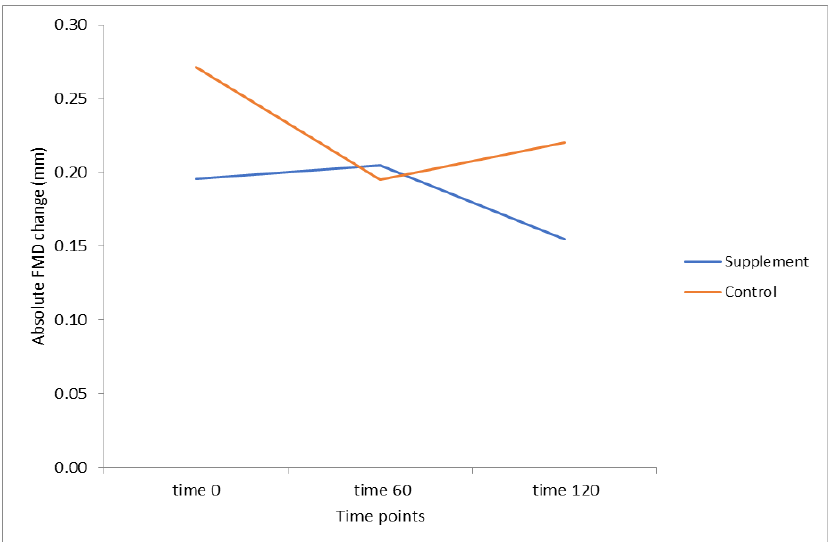
Figure 1. The effect of Treatment * Time Interaction on Absolute FMD.